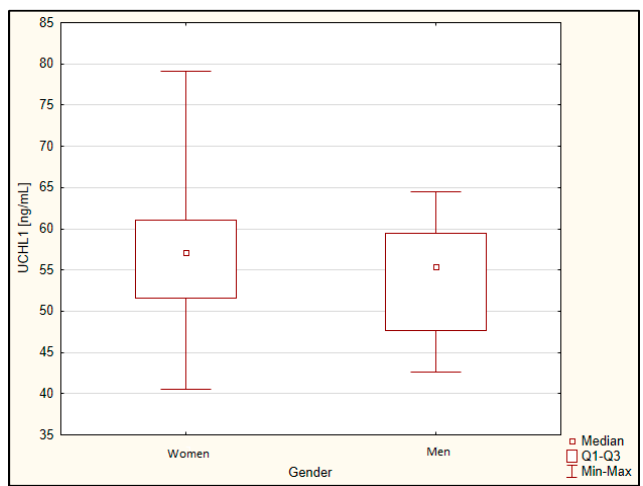
Figure 1. Concentration of UCHL1 depending on gender. Q1, lower quartile; Q3, upper quartile.